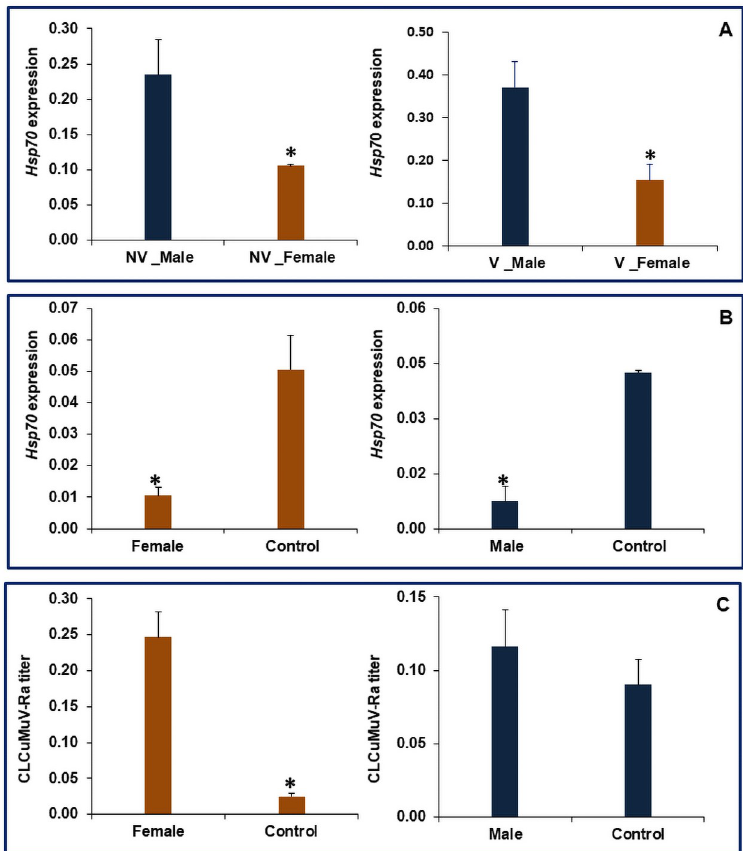
Fig 8. Relative expression of Hsp70 in B . tabaci , A. Non-viruliferous and Viruliferous whiteflies, B. dsRNA fed female and male whiteflies; C. Relative titer of Cotton leaf curl Multan virus -Rajasthanin Hsp70 knockdown viruliferous female and male whiteflies. The expression level was normalized with β -tubulin as housekeeping gene. Error bars represent the standard deviation (n = 3) and � represents significant differences in expression (P � 0.05, Student’s t-